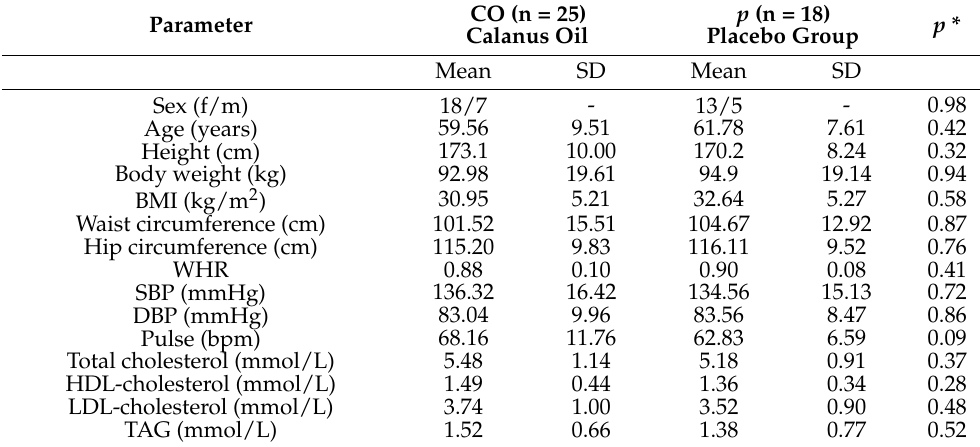
Table 2. Sex, age and anthropometric parameters of the study population at